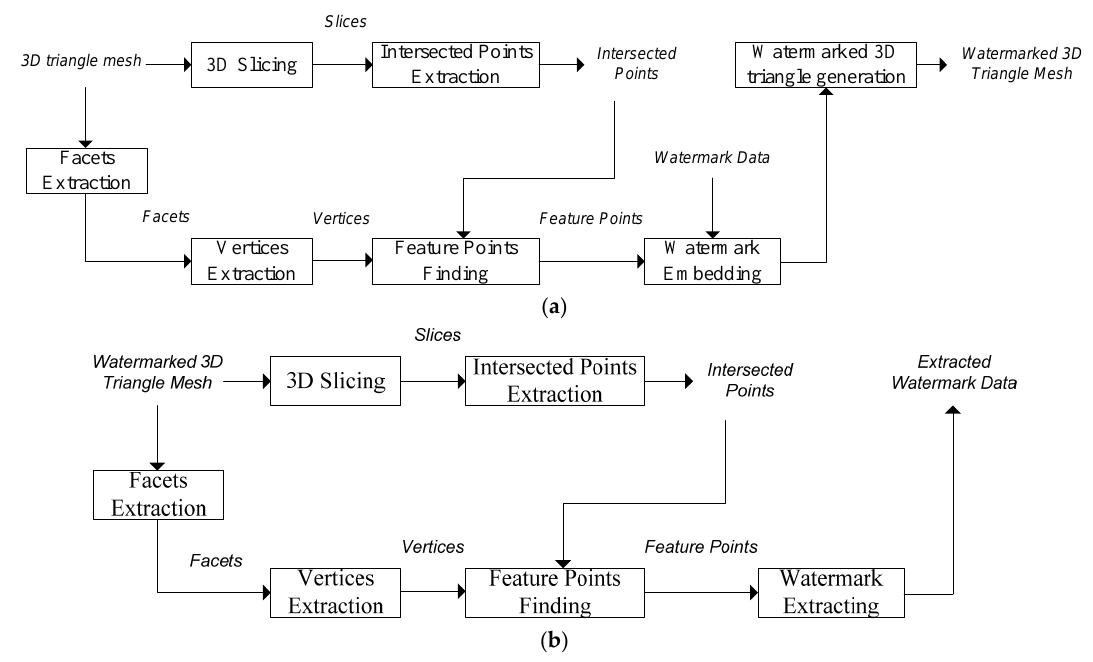
Figure 2. The proposed algorithm: ( a ) watermark embedding and ( b ) watermark extraction.